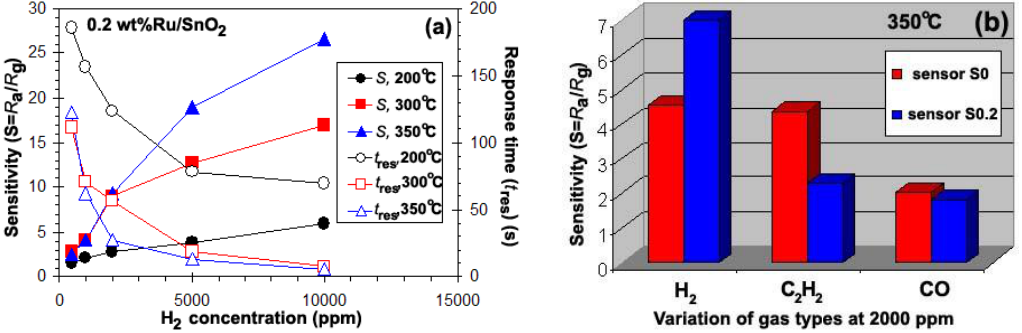
Figure 7. (a) Sensing performance in the terms of the sensitivity (filled symbols, left axis) and corresponding response times (open symbols, right axis) of 0.2 wt%Ru/SnO sensors as a function of H concentration in dry air at 200 °C (circles), 300 °C (rectangles), 2 and 350 °C (triangles). The sensitivity increased and the response times decreased with increasing H concentration and operating temperature. (b) Selectivity histogram of pure 2 SnO and containing 0.2 wt%Ru for different gases (0.2%vol) at 350 2